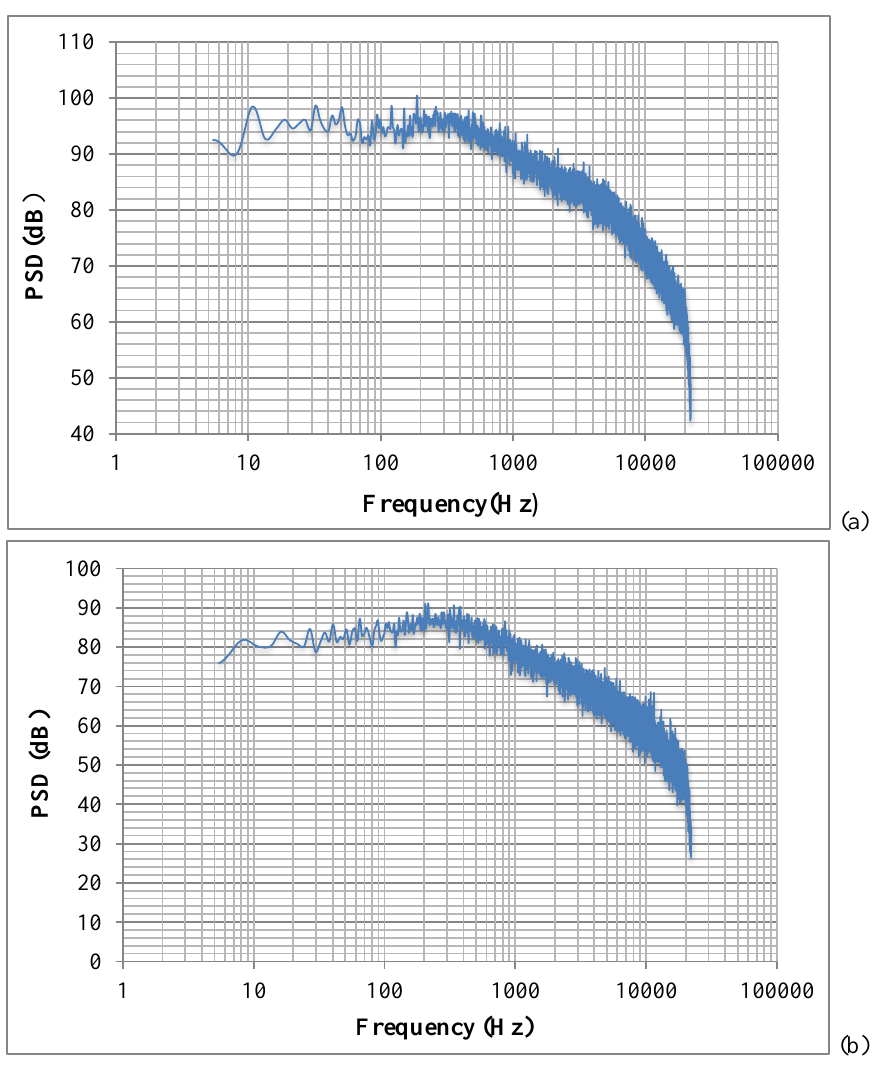
Figure 3. (a) Sound level in X-direction, (b) sound level in Z-direction (120